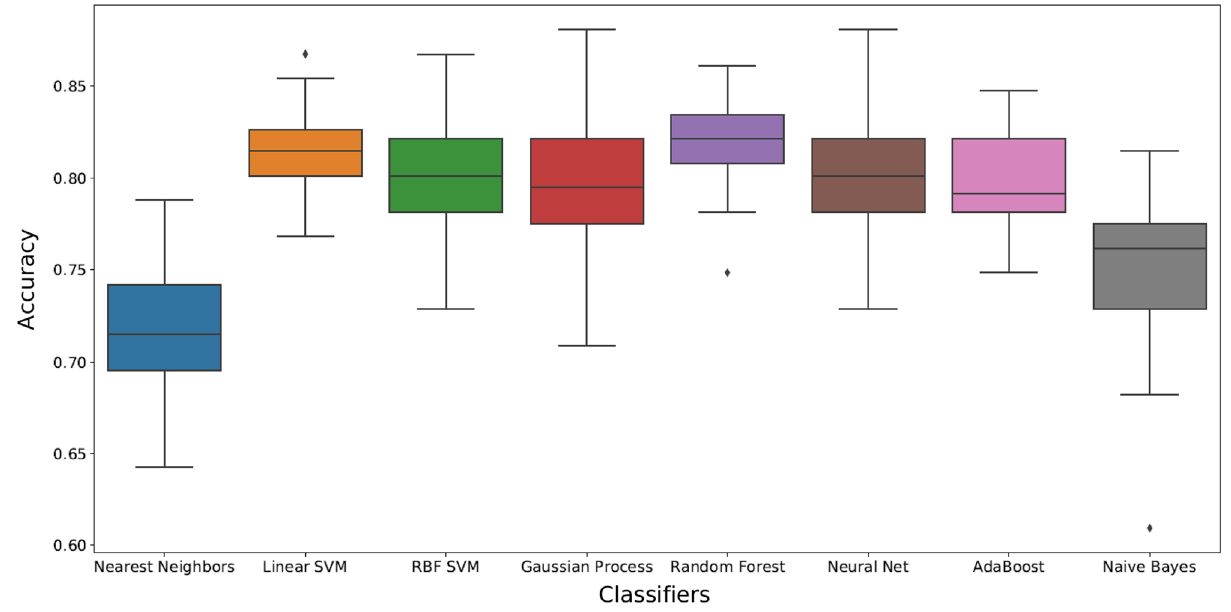
Figure 1. Box plots showing different classification methods applied to the dataset for presence of fatty liver. Box plots are generated by performing 50 individual runs for each classifier. This will assure that the achieved results are reliable.